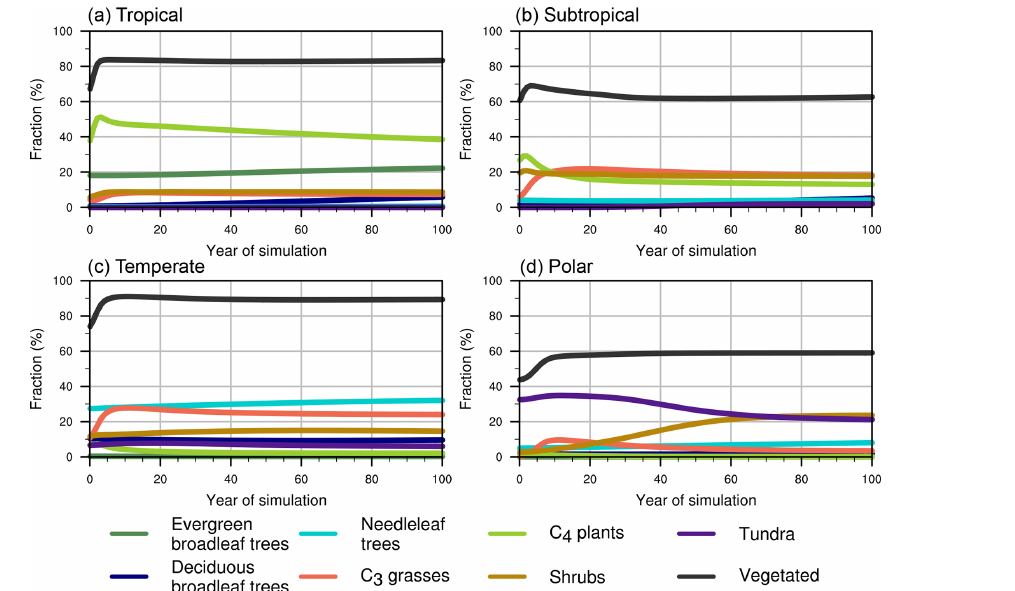
Figure 1. Fractional coverage of each plant functional type in typical climate zones in the equilibrium